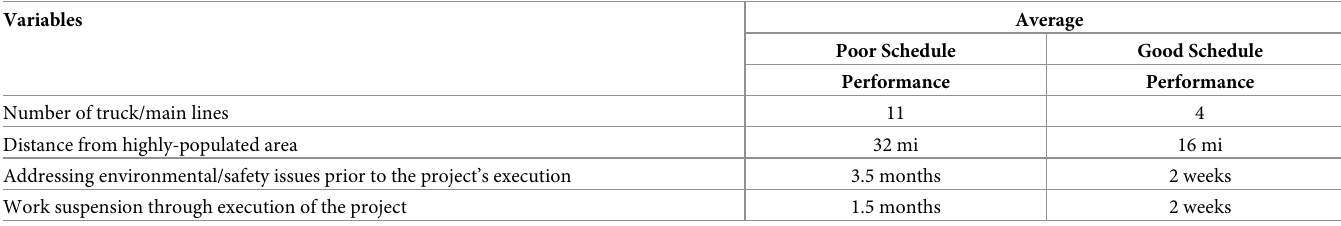
Table 6. Comparison of variables with continuous data in reconstruction projects with good and poor schedule performance. Variables